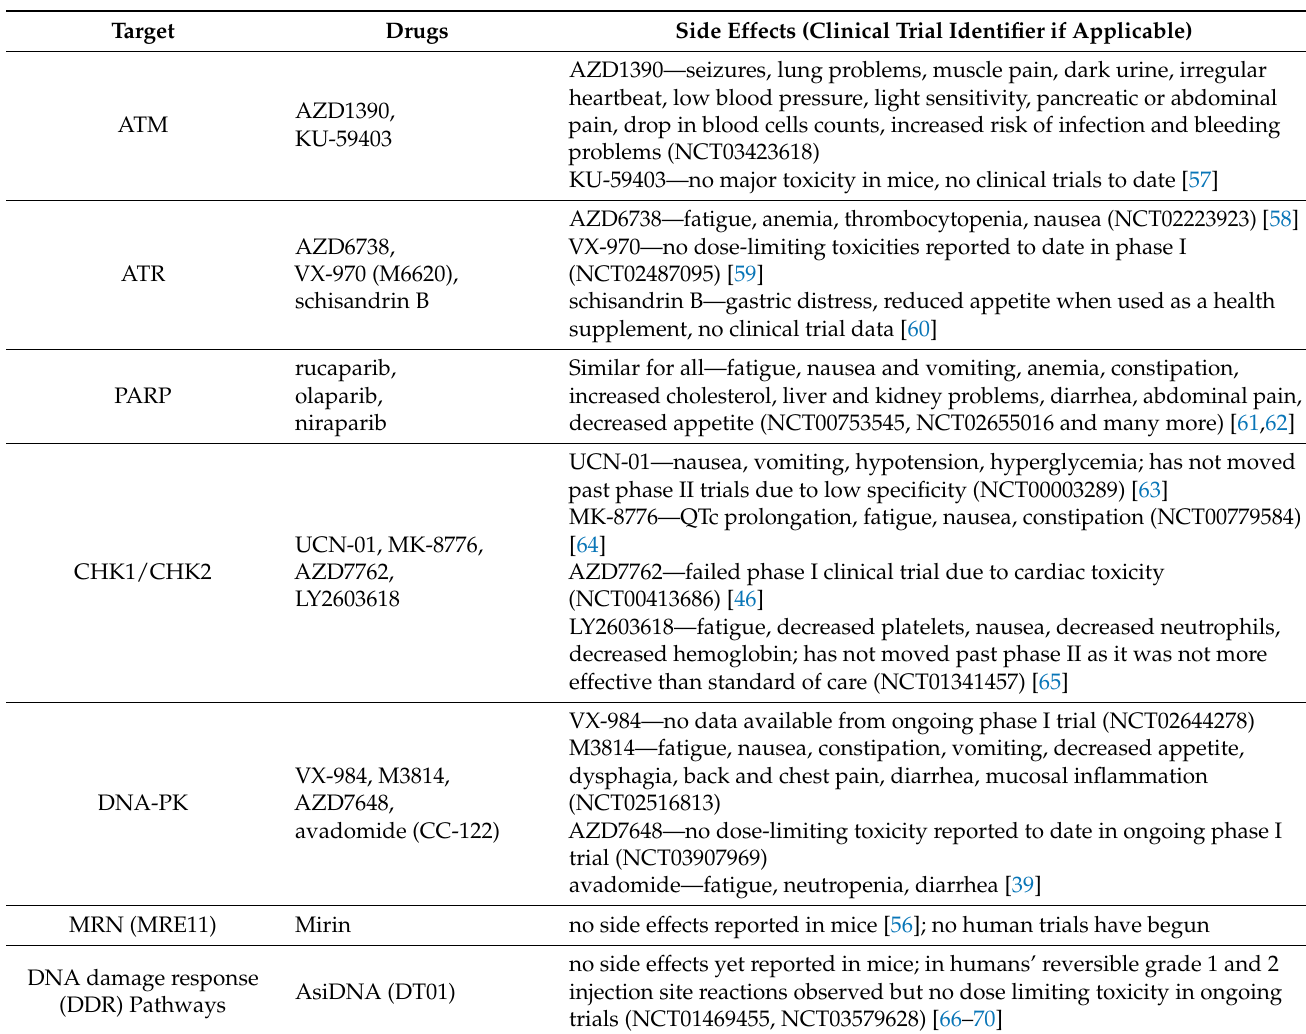
Table 1. List of DNA repair inhibitors that target the double strand break system and their utility in